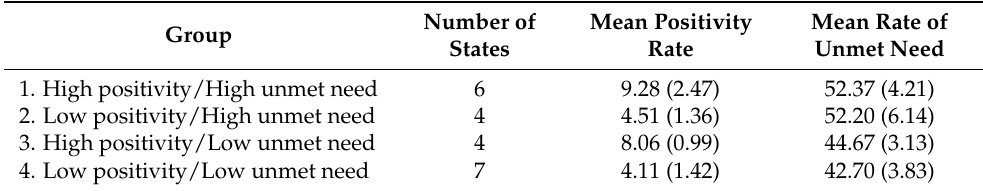
Table 2. Mean rates of coronavirus positivity and unmet need for mental health services for children and adolescents. Group